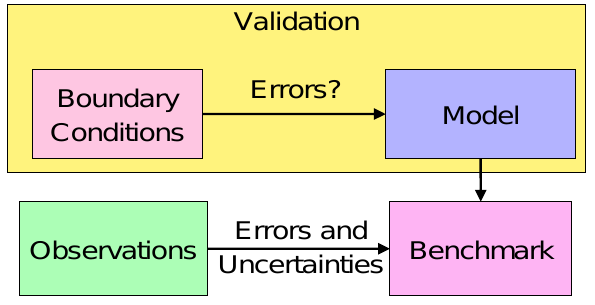
Fig. 2. Sketch of an intercomparison of modelling data to observa- tional data, illustrating the difficulties in attributing discrepancies to model deficiencies rather than input or boundary data